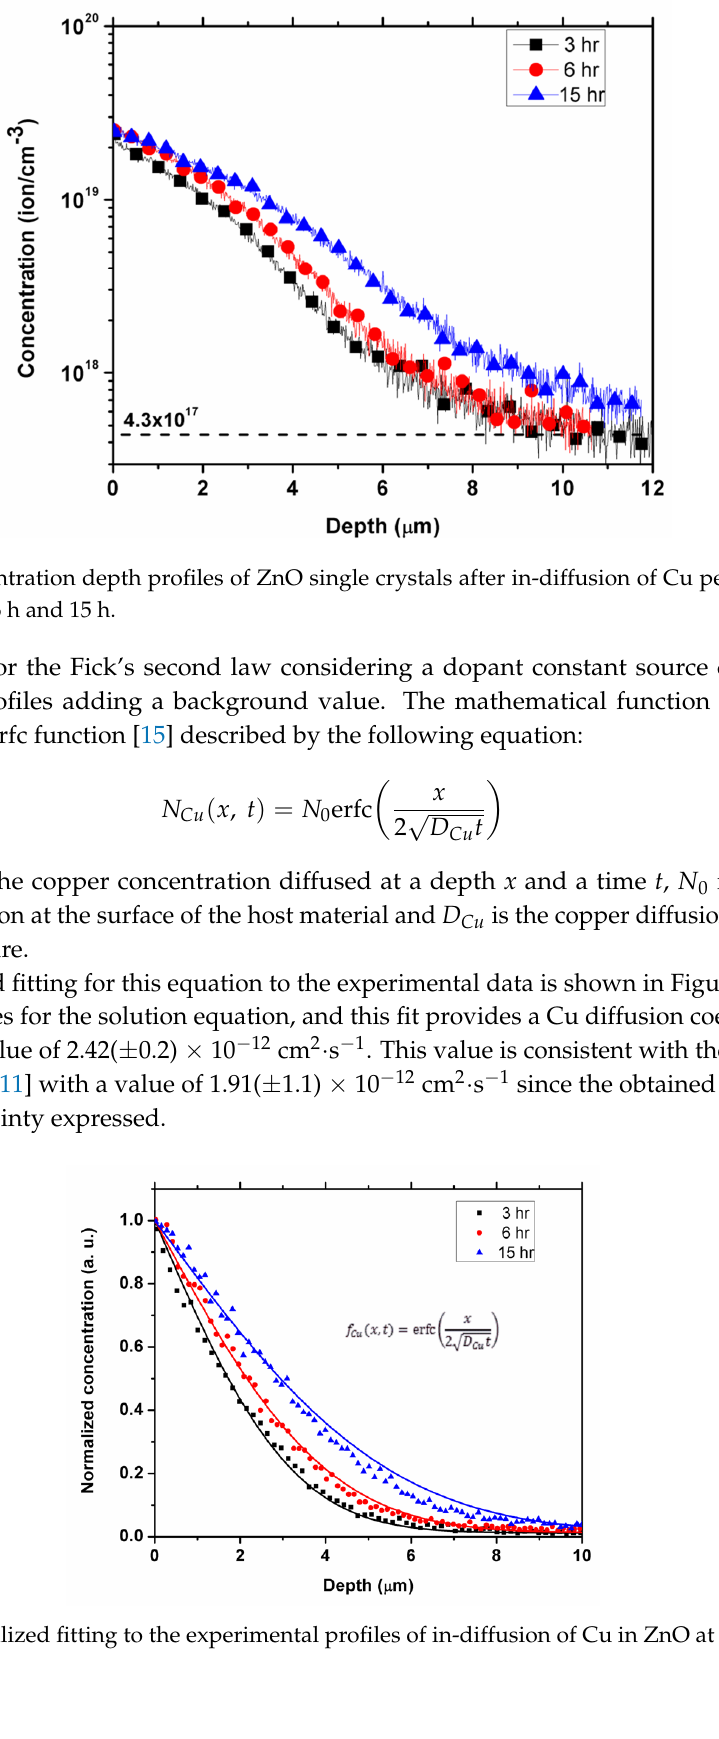
Figure 2. Normalized fitting to the experimental profiles of in-diffusion of Cu in ZnO at 1000 °C for 3 h, 6 h and 15 3h, 6h and 15h.